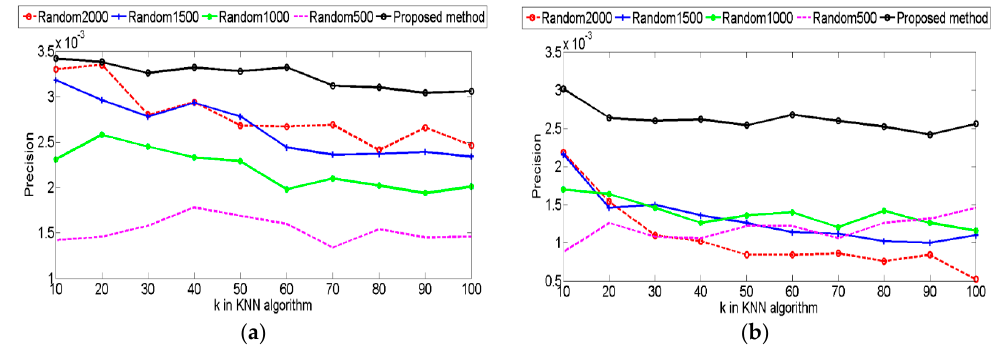
Figure 3. ( a ) Recall criterion with similarity measures of cosine; ( b ) Recall criterion with similarity measures of NHSM.